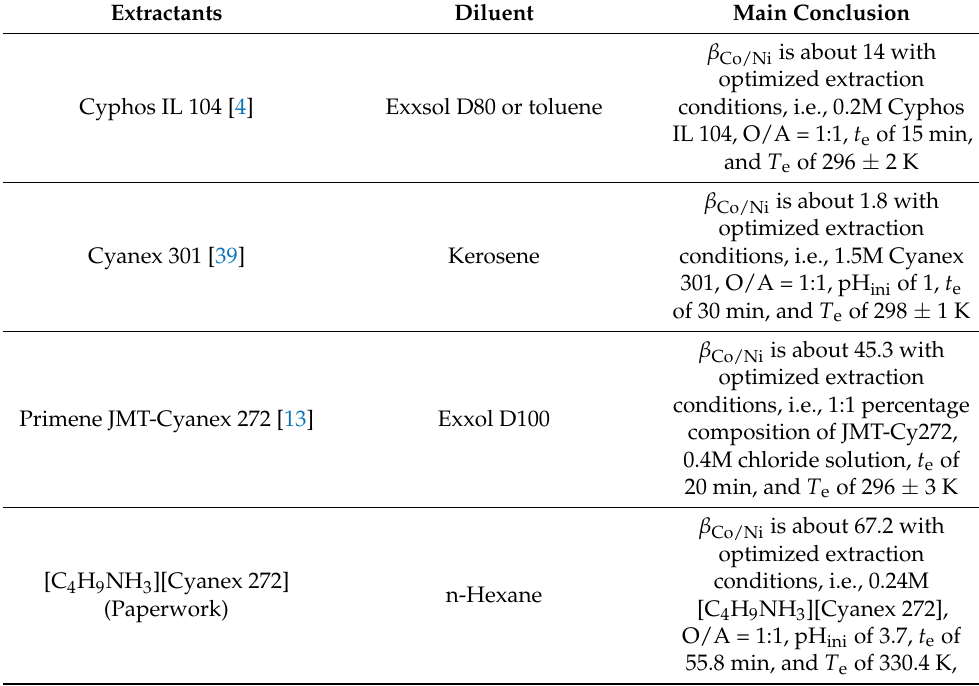
Table 4. Comparison of separation factor of Co 2+ from Ni 2+ using single-stage